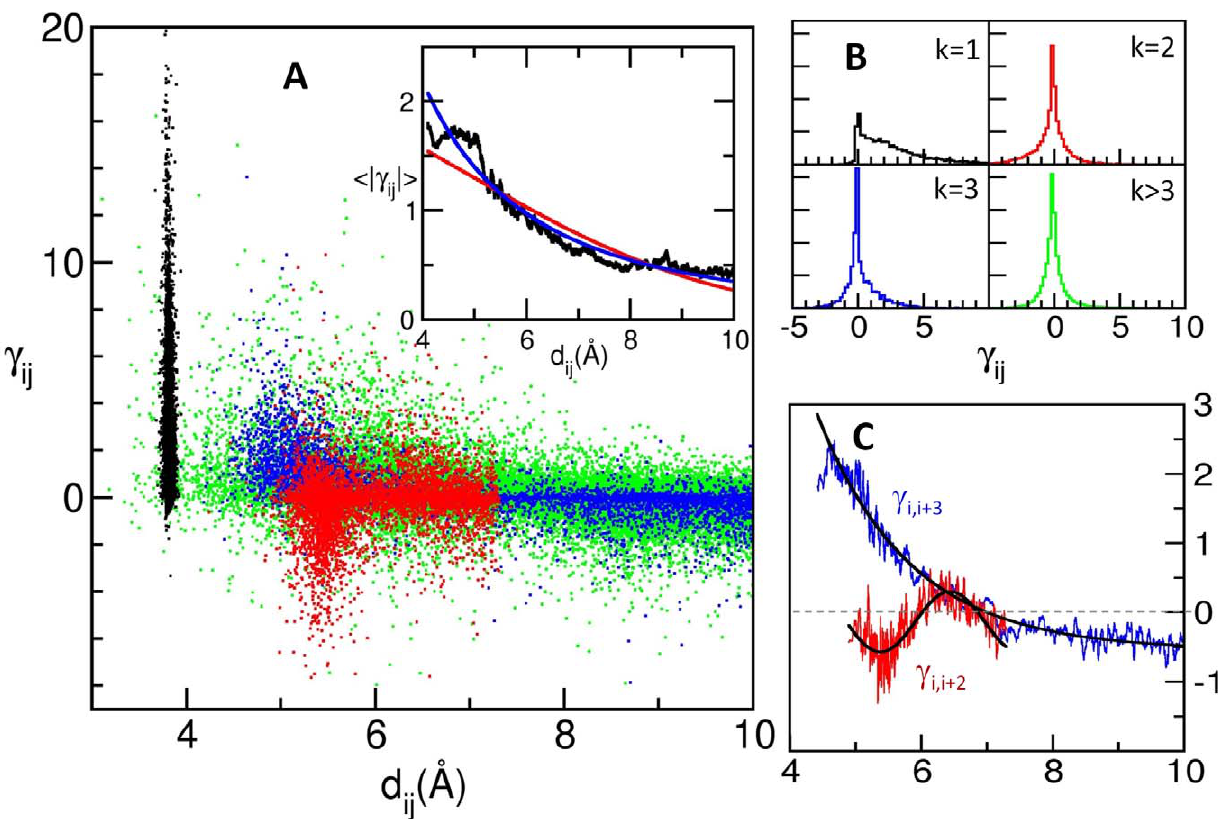
Figure 1. All interactions, colored by contact order. (A) The abscissa displays the distance d ij between residues and the ordinate is the optimized force constant (OFC) deduced from experimental covariance data for the interaction. The black cluster around 3.8A˚ indicates bonded ( k =1) interactions; the red cloud between d ij =5 and 7.5A˚ corresponds to second neighbor ( k =2) interactions; the blue points indicate k =3 interactions; and the green points in the background indicate all other interactions. Inset shows the trend of average force constant magnitude with distance between nodes (heavy black curve), and two functional fits: red line is 2.26 exp( 2 d ij 2 /46.31); blue line, 31.93/d ij 2 . (B) Histograms of the distributions in (A), by contact order. Mean values and standard deviations, m k 6 s k , for each curve are m 1 =2.897 6 3.000; m 2 = 2 0.205 6 1.035; m 3 =0.385 6 1.366; m . 3 =0.067 6 1.124. (C) Trends for the k =2 and k =3 distributions, with the same colors and axes as in (A). The k =2 interactions are fit to a sinusoidal function with extrema around 5.5A˚ and 6.5A˚. The k =3 interactions tend to be positive for small distances ( , 7A˚) and negative for larger distances, decaying exponentially.